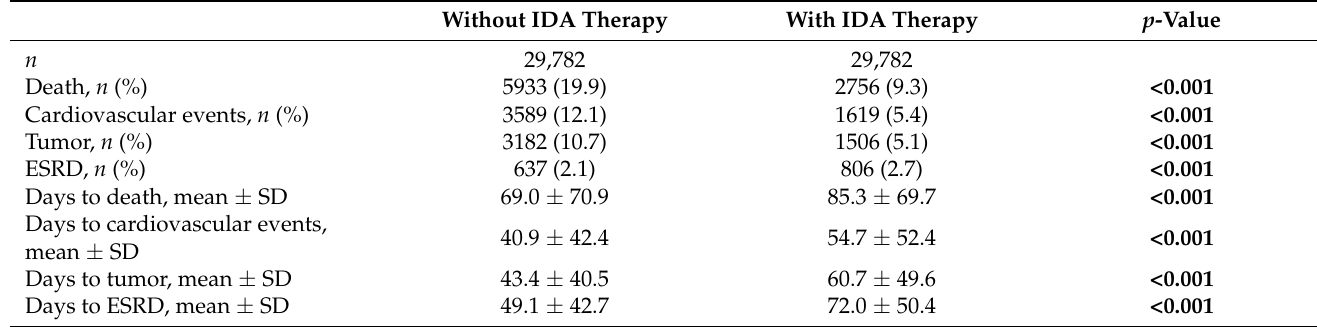
Table 2. Clinical outcomes analysis in ND-CKD-IDA patients treated or not with IDA therapy, post PSM. Significant p -values are highlighted in bold.